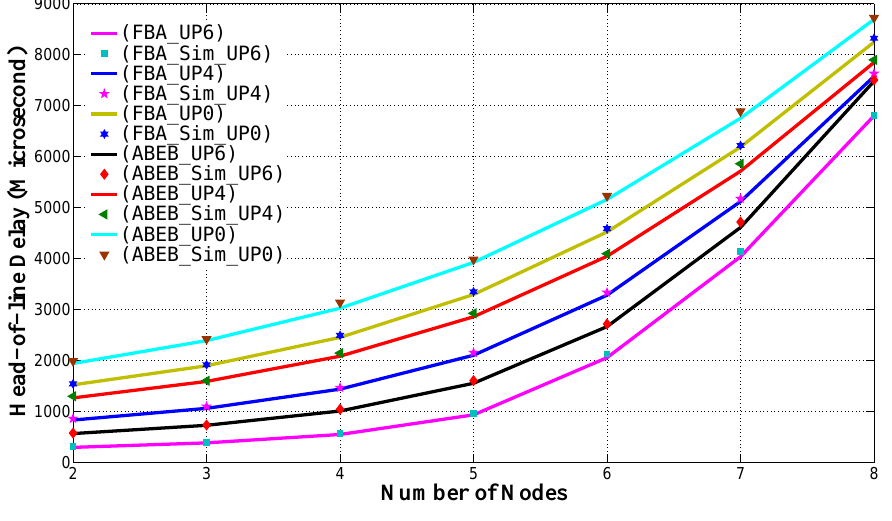
Figure 11. Mean frame service time in the homogeneous case for different backoff algorithms.